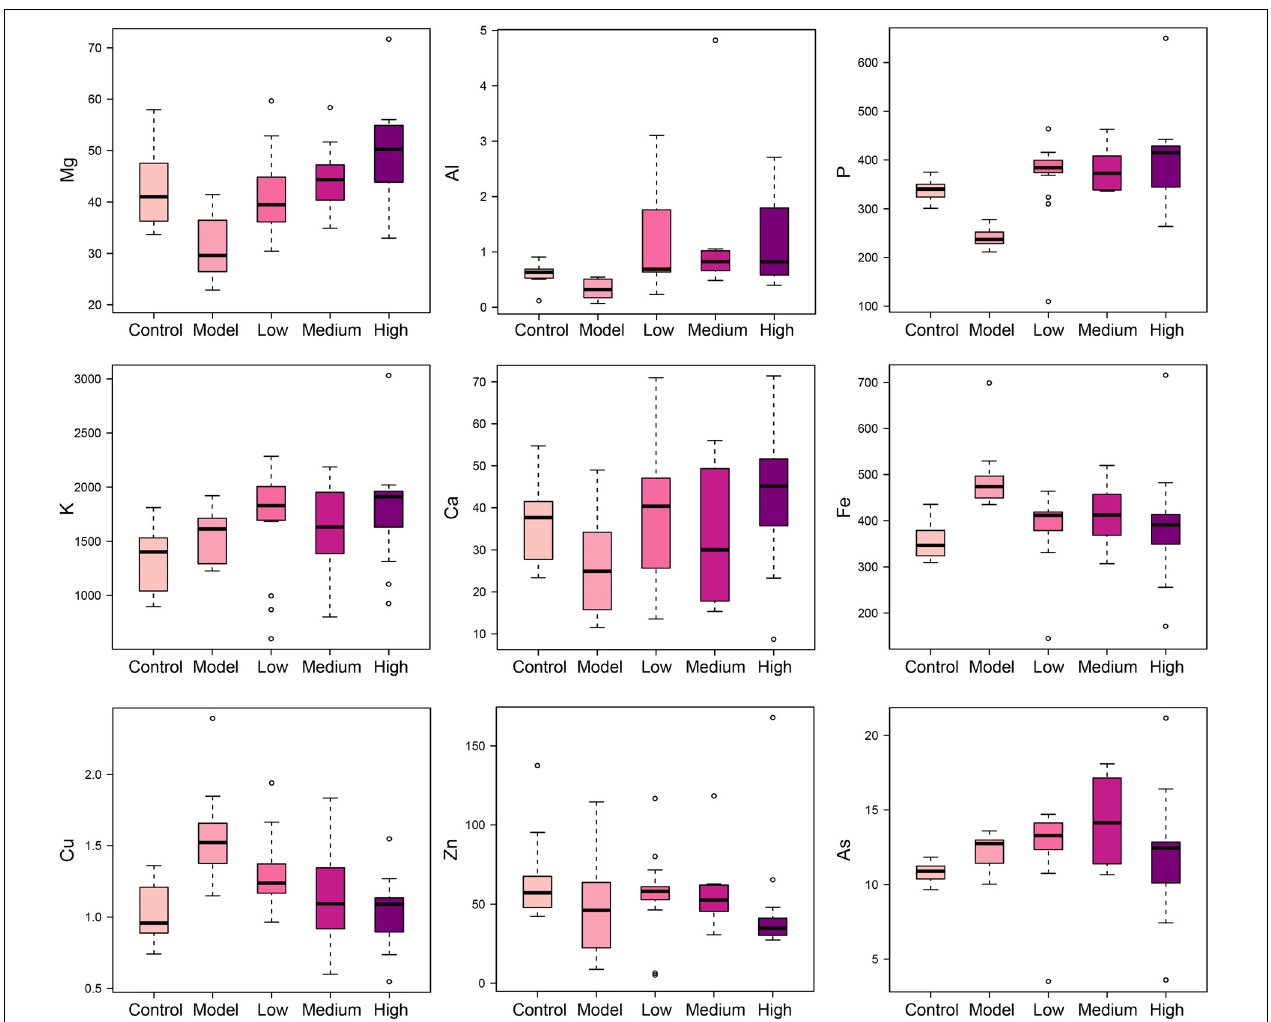
FIGURE 4 | Boxplots of elements levels in serums of rats form control, model, and low, medium, and high dose of SWGNP treated groups. The boxes cover 25% quartile and 75% quartile of the data. The line in the box represents the median value. The extended whiskers show the extent of the rest of the data, and outliers are shown as open